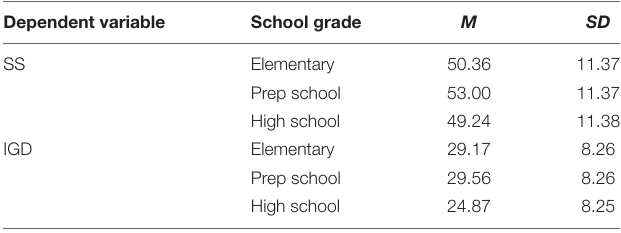
TABLE 7 | Post hoc analysis of univariate analysis of variance (ANOVA) for internet gaming disorder (IGD). Dependent variable